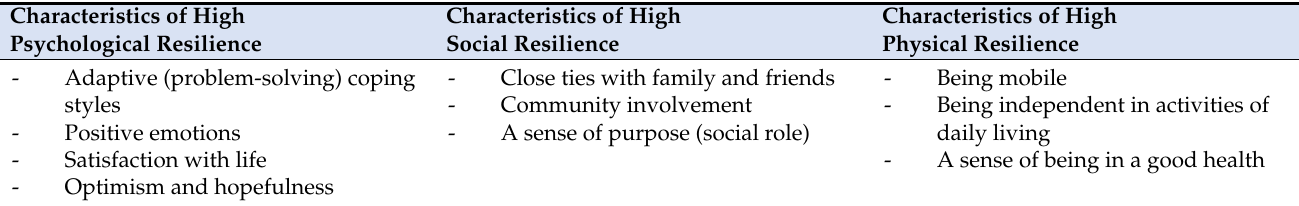
Table 2. Characteristics of psychological, social, and physical resilience found to be associated with positive health- related